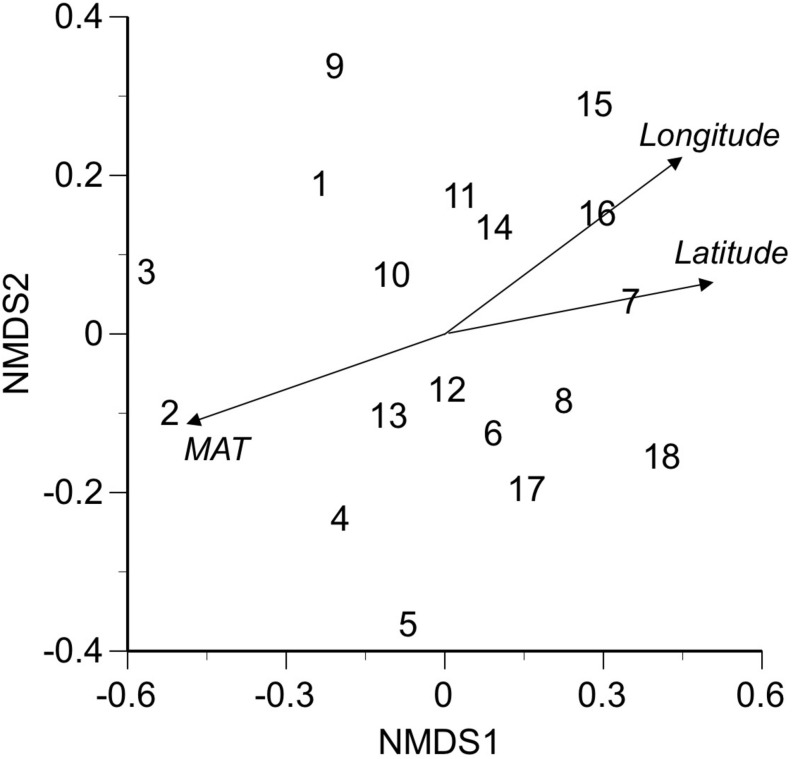
Multivariate ordination of fungal assemblages in bleached portions of leaf litter at 18 sites, using nonmetric multidimensional scaling (NMDS, stress value = 0.154). Site numbers and abbreviation are as in Table 1. Three variables (latitude, longitude, MAT; italicized) with significant effects are indicated by arrows.